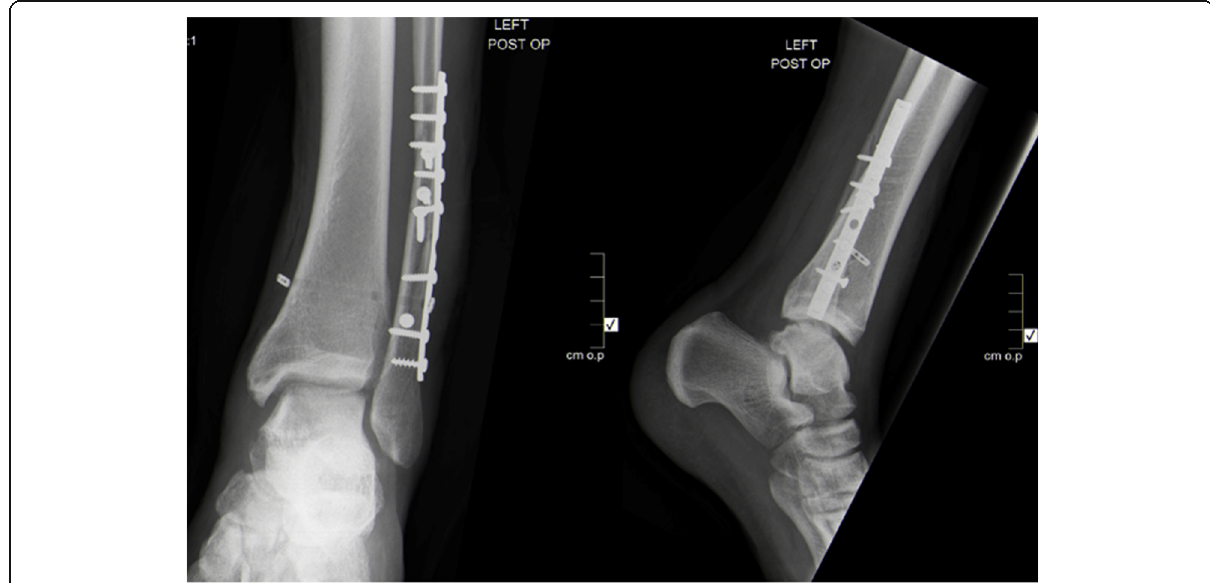
Fig. 3 Anteroposterior and lateral plain ankle radiographs after the second operation demonstrating the exchange of the proximal syndesmotic screw with a suture